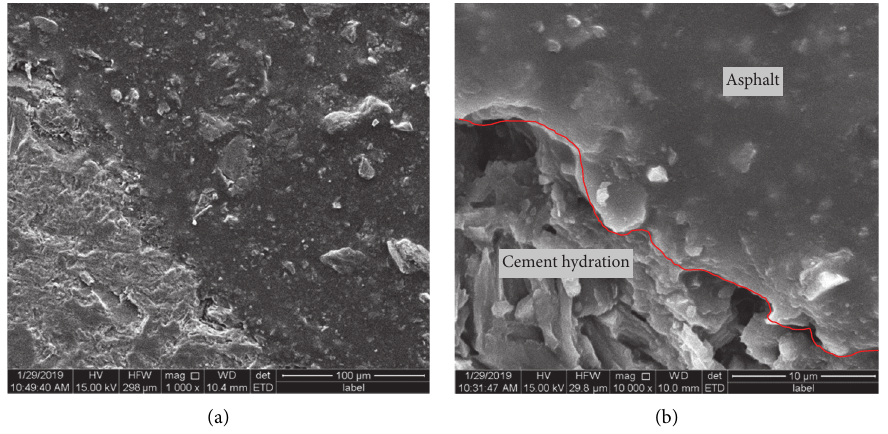
Figure 17: Morphology of SFP sample cured by 3 days. (a) Scale bar � 100 μ m. (b) Scale bar � 10 μ